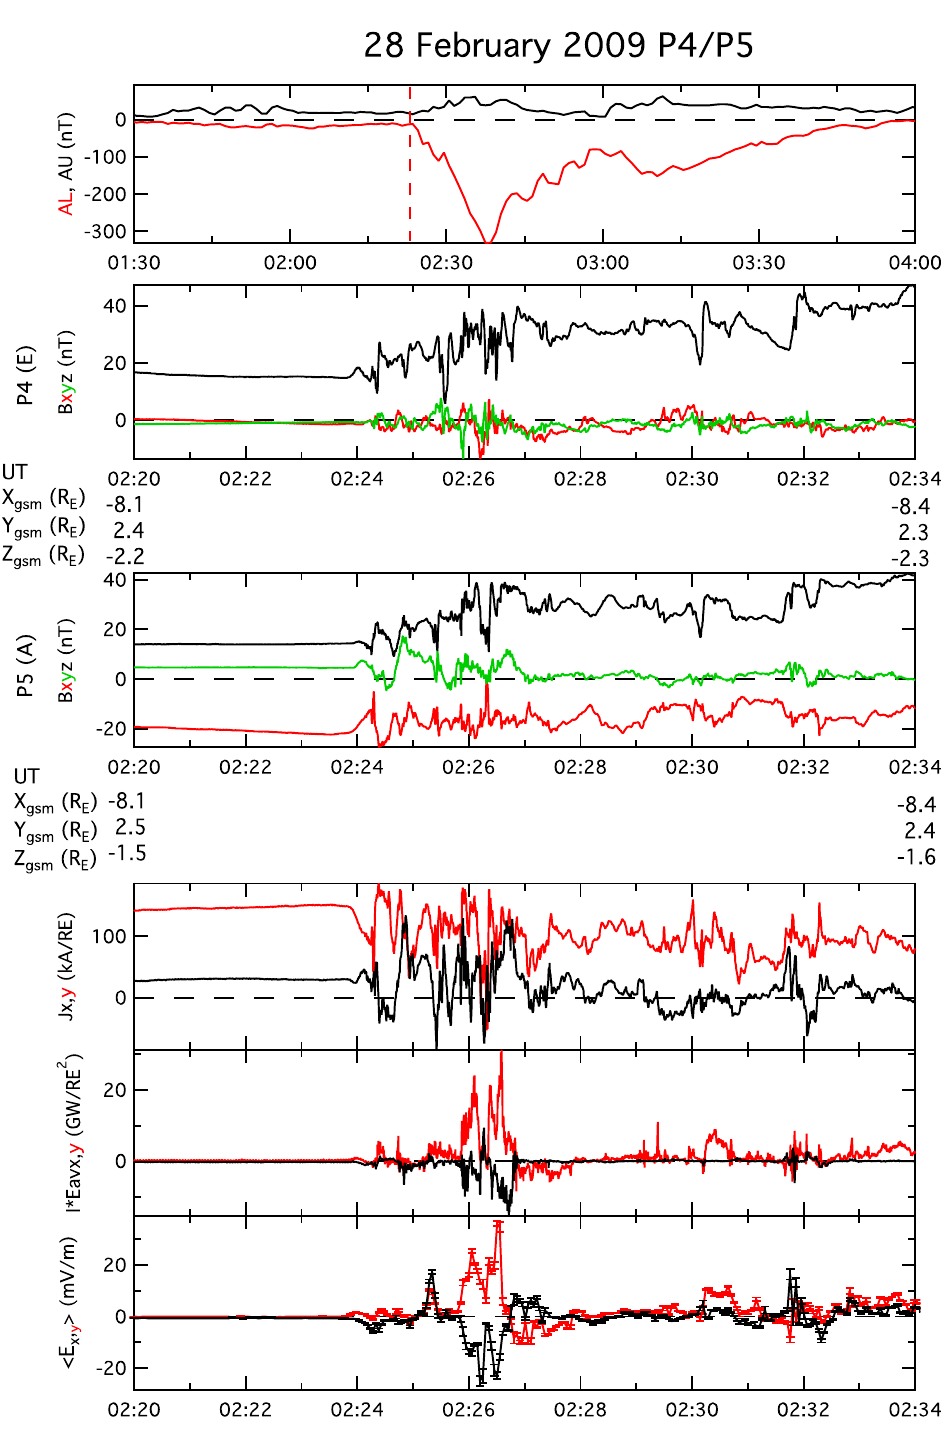
Figure 6. Observations of CD on 28 February 2009 showing the AU/AL (auroral upper/auroral lower) indices, the magnetic field components in GSM coordinates at P4 and P5, current densities in the layer embedded by P4 and P5, power within the layer, and the average electric field at the two satellites at